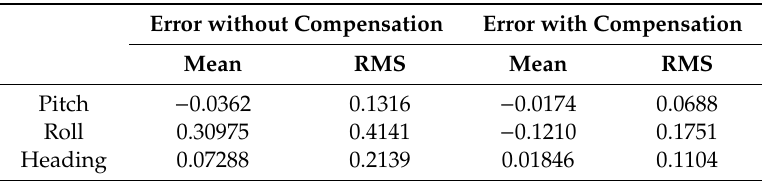
Table 12. Statistical Error